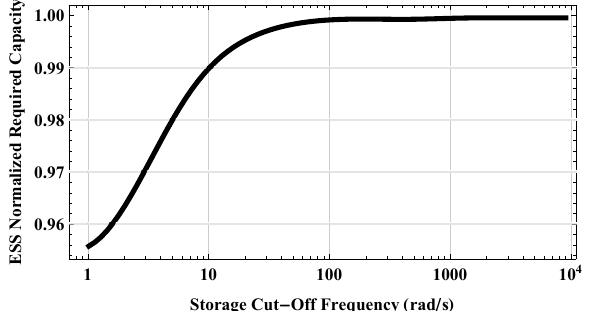
Figure 12. dc voltage variation against ESS cut-off frequency sweep.